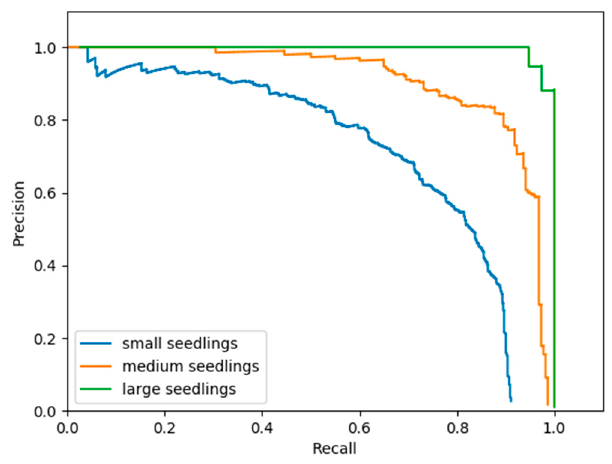
Figure 3. Precision–recall curves from faster R-CNN for small, medium, and large seedlings.